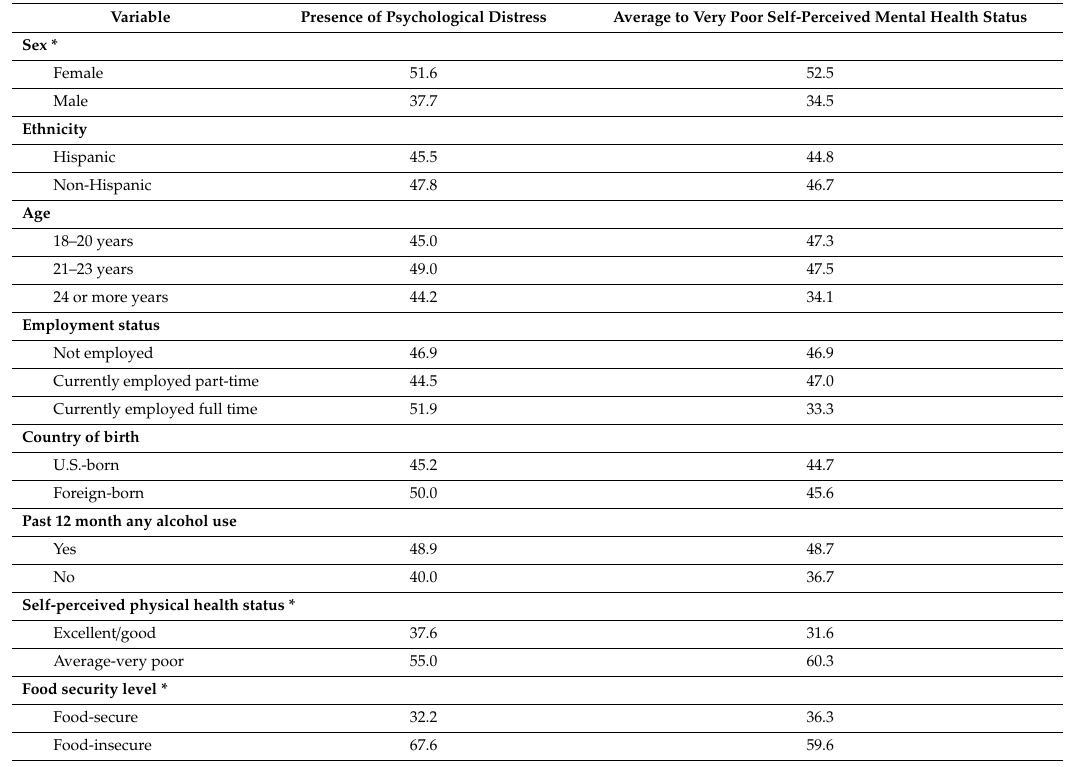
Table 2. Factors associated with the presence of psychological distress and a low self-perceived mental health status.